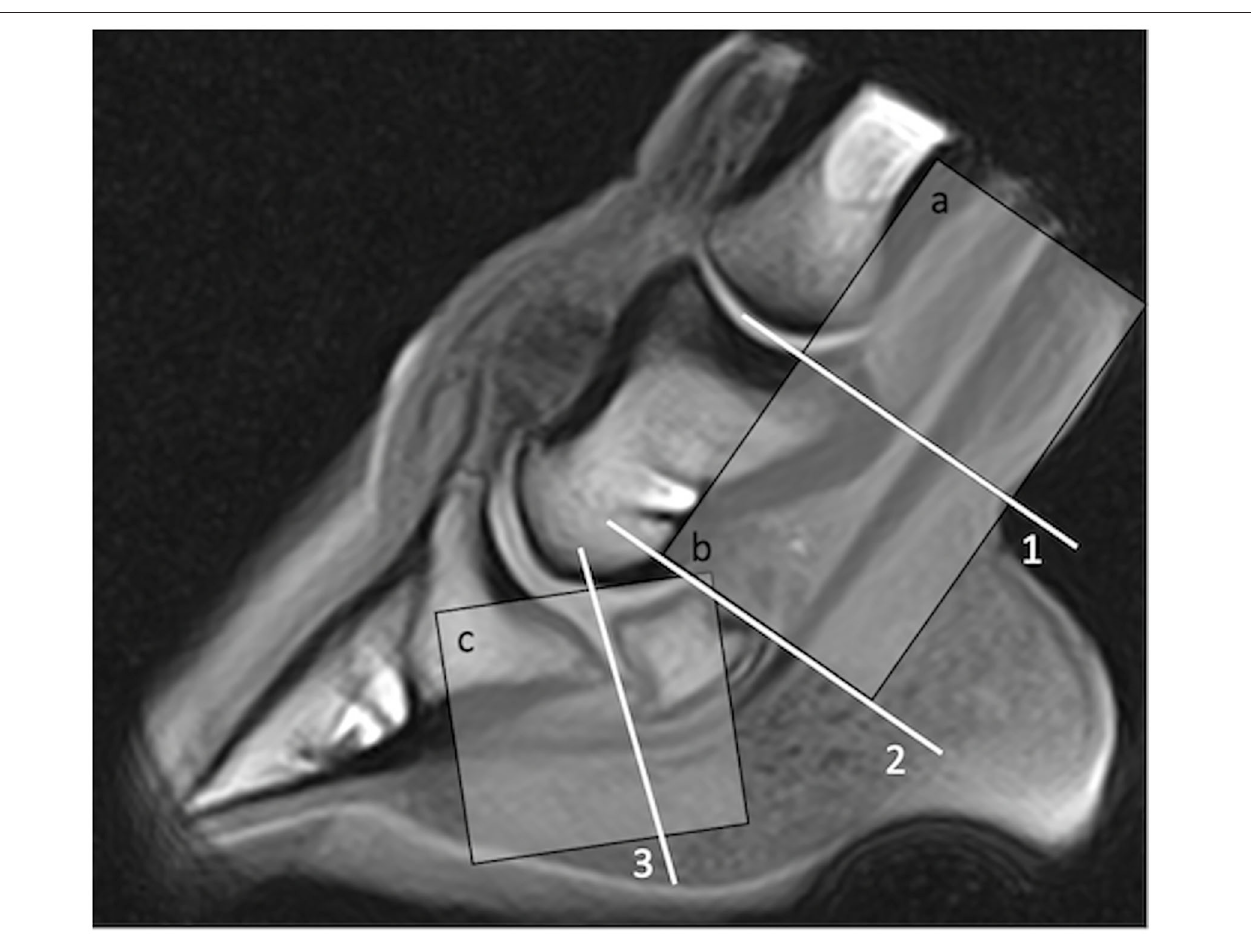
FIGURE 1 | Proximo-distal levels used to describe deep digital flexor tendon lesion location at magnetic resonance (MR) imaging (1, suprasesamoidean; 2, sesamoidean; 3, infrasesamoidean) and at ultrasonography (a, pastern; b, suprasesamoidean; c; distal sesamoidean and infrasesamoidean explored together with transcuneal approach). Region a (pastern) was not imaged using MR in this